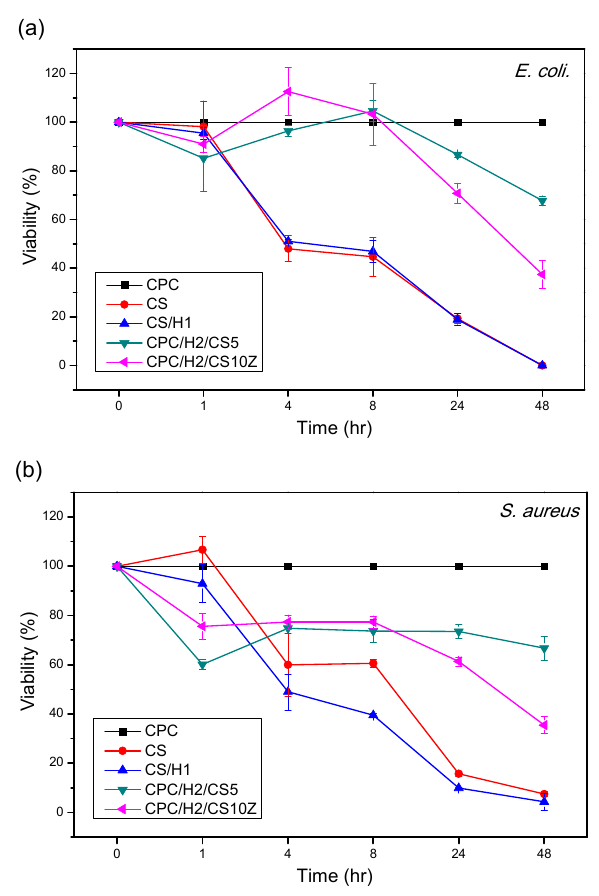
Figure 6. Relative viability of S. aureus ( a ) and E. coli ( b ), cultured in PBS for up to 48 h. The time profiles of bacteria viabilities indicate the inhibition ability of CS, CS/H1, CPC/H2/CS5, and CPC/H2/CS10Z (optical density percentages at 600 nm normalized to CPC as 100%). After setting for 1 h, the XRD patterns (Figure 7a) revealed that the phase structures remained mostly similar to the original CPC powder obtained after mixing TTCP (JCPDS 25-1137) and DCPA (JCPDS 71-1759). The CS phase was not observed in the diffraction patterns of CPC/H2/CS5, CPC/H2/CS5Z, and CPC/H2/CS10 (Figure 7a, lines C, D, and E, respectively). However, the CS (JCPDS #42-0551) phase was clearly observed in the diffraction pattern of CPC/H2/CS10Z. The diffraction peaks at 29.55°, 32.27°, 32.76°, and 34.55° in CPC/H2/CS10Z were assigned to the (2 2 1)/( − 4